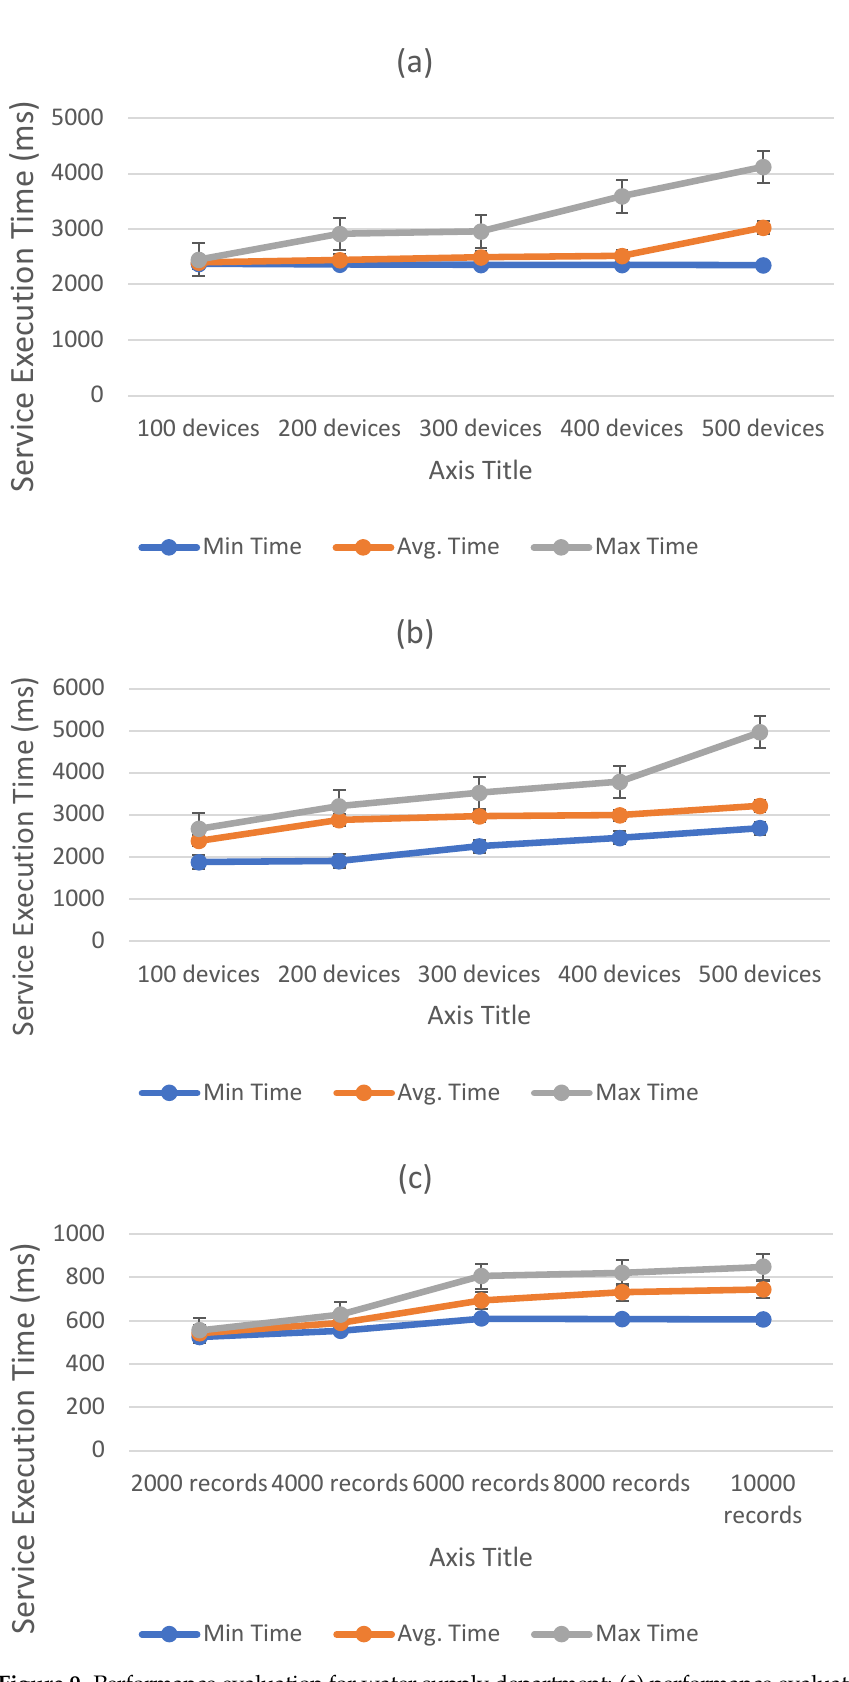
Figure 9. Performance evaluation for water supply department: ( a ) performance evaluation for device creation; ( b ) performance evaluation for sensor reading; ( c ) performance evaluation for query processing.